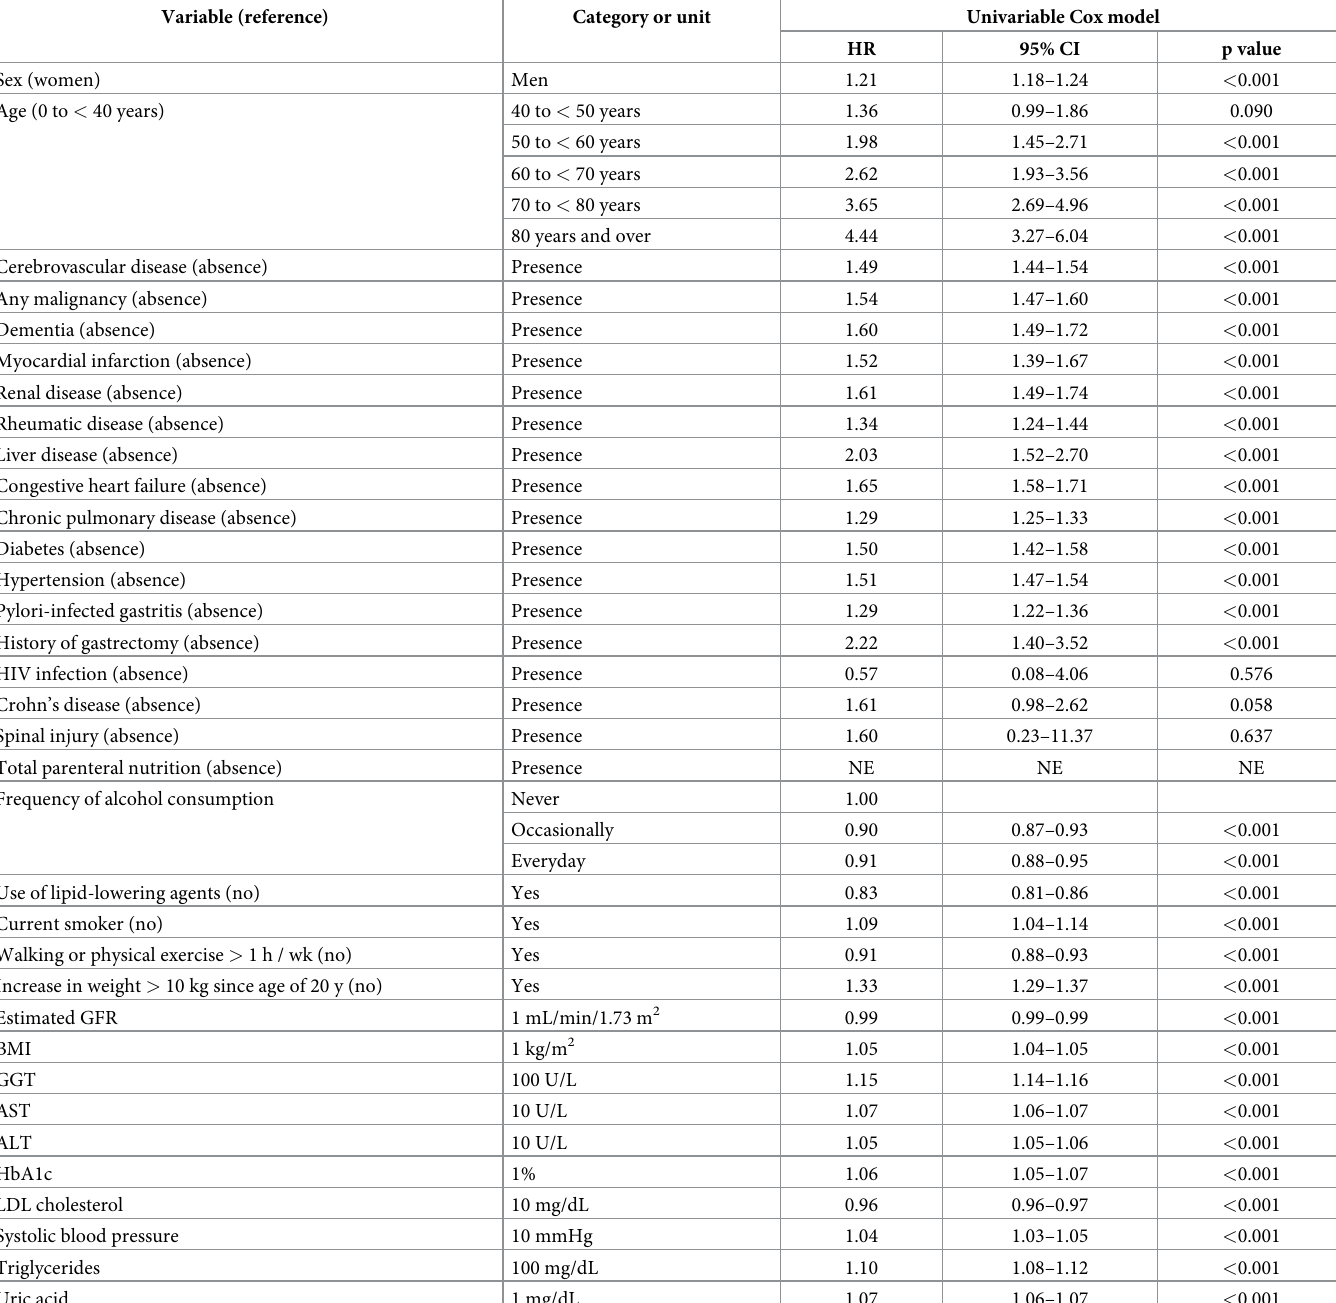
Table 2. Results of univariable Cox model